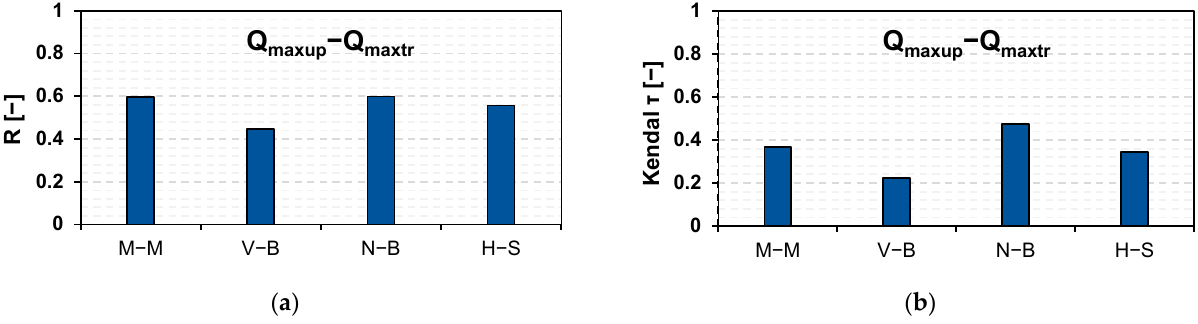
Figure 5. ( a ) Pearson correlation R of the maximum annual discharges and ( b ) Kendall’s rank correlation τ of the maximum annual discharges.